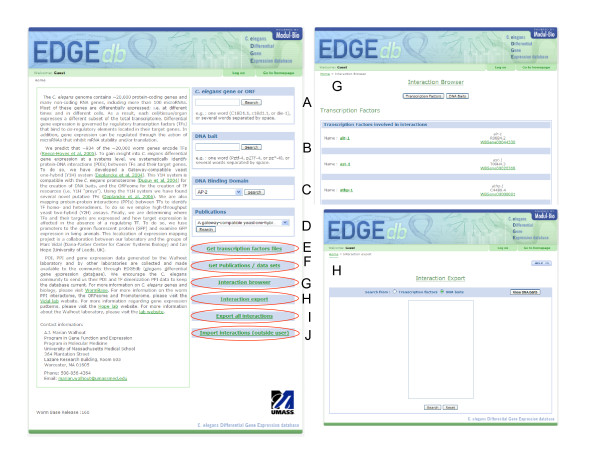
EDGEdb home page. This page contains an introduction to the database (left). The home page also provides links to several tools to explore and download the data (right): (A) Text field to search for C. elegans genes. (B) Text field to search for DNA baits (e.g. a promoter). (C) Scroll down menu to retrieve TFs by DNA binding domain. (D) Scroll down menu to retrieve publications and associated experiments. (E) Link to the collection of C. elegans TFs. (F) Yeast one -and two-hybrid datasets and pdf files of corresponding publications. (G) Interaction browser. (H, I) Export tools. (J) Import interaction tool for outside users. The WormBase release used is specified at the bottom left corner of the page.